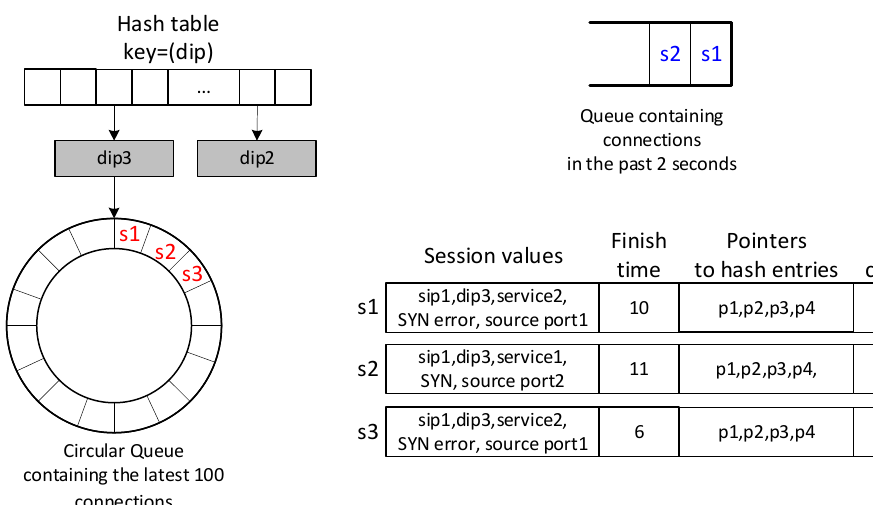
Figure 4. Examples of two queues and corresponding session entry structures. The circular queue contains three sessions while the linear queue contains two sessions.